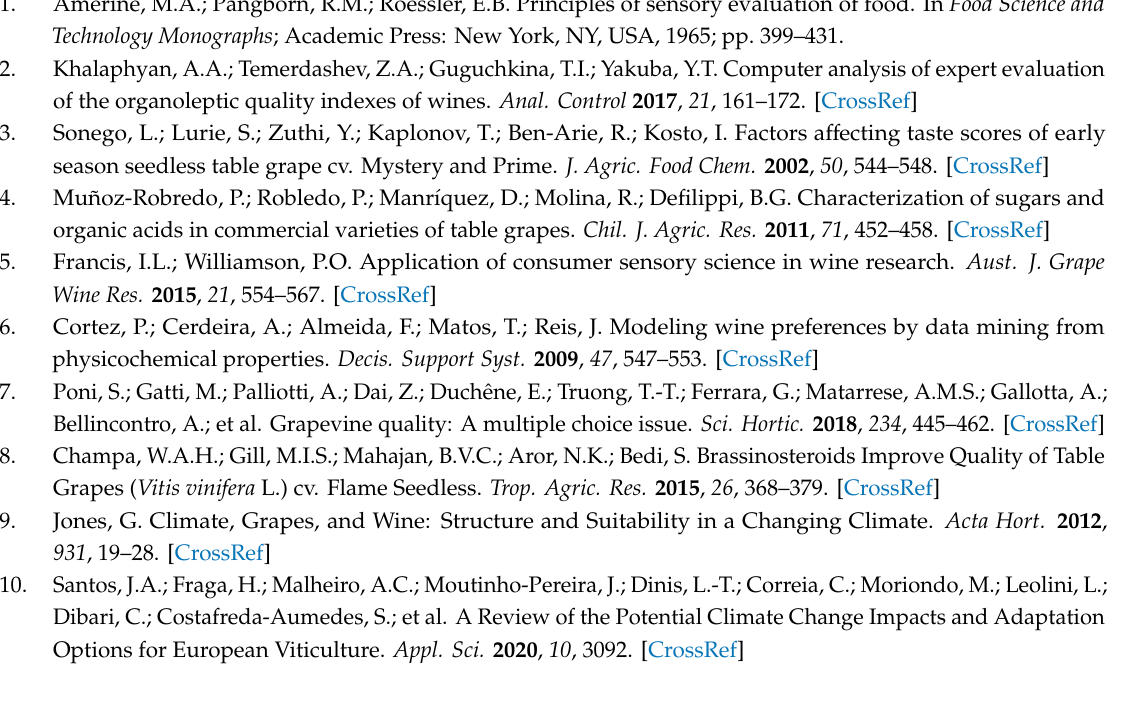
Table S1. Characteristics of 232 grape varieties in conditions of the Don Ampelographic Collection, 1981–2019, Table S2. The correlation coe ffi cients between the tasting scores of fresh berries and wine of the “average variety” with agrometeorological